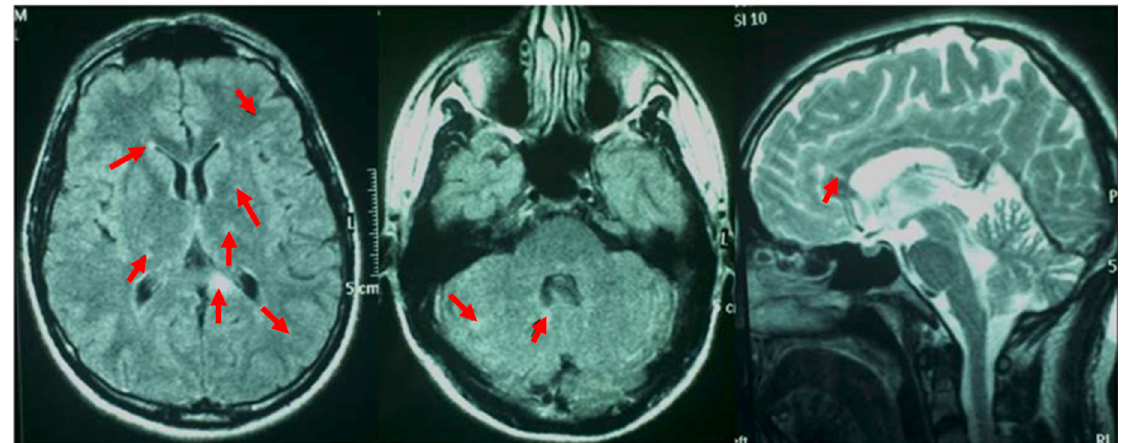
Figure 1. Magnetic resonance of the brain: the red arrows show various rotund and ellipsoid focal lesions involving the corpus callosum, periventricular and subcortical white matter, deep grey matter (basal ganglia and thalami), and cerebellum.